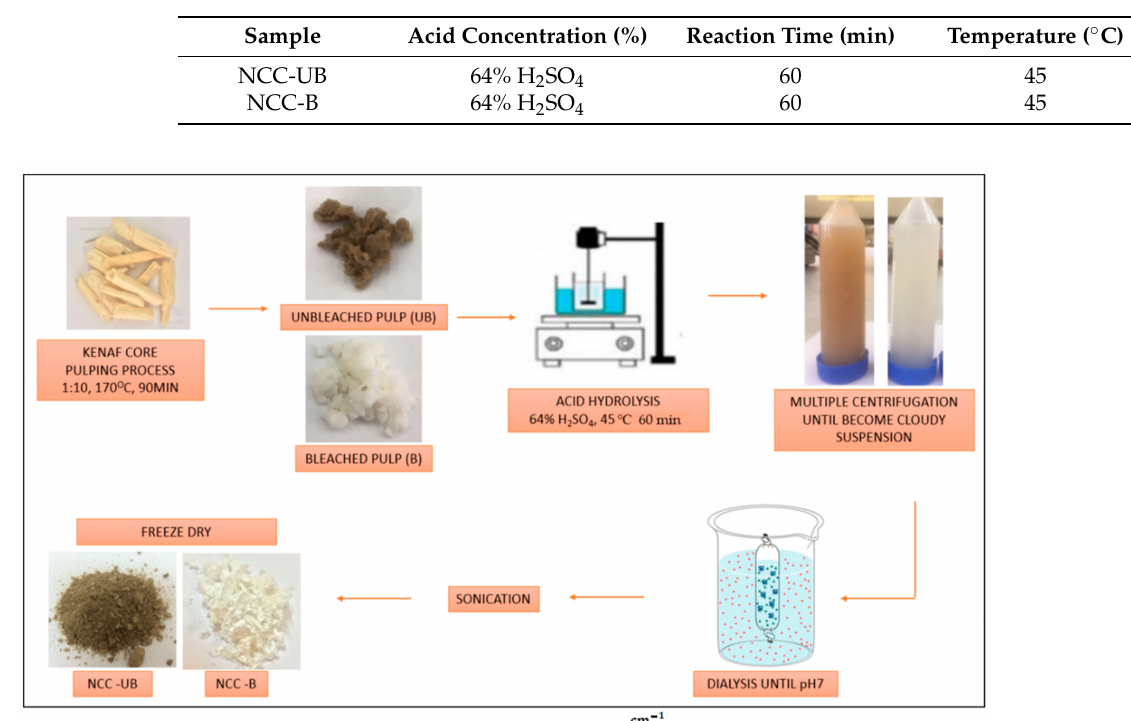
Figure 1. The schematic diagram of unbleached and bleached NCC